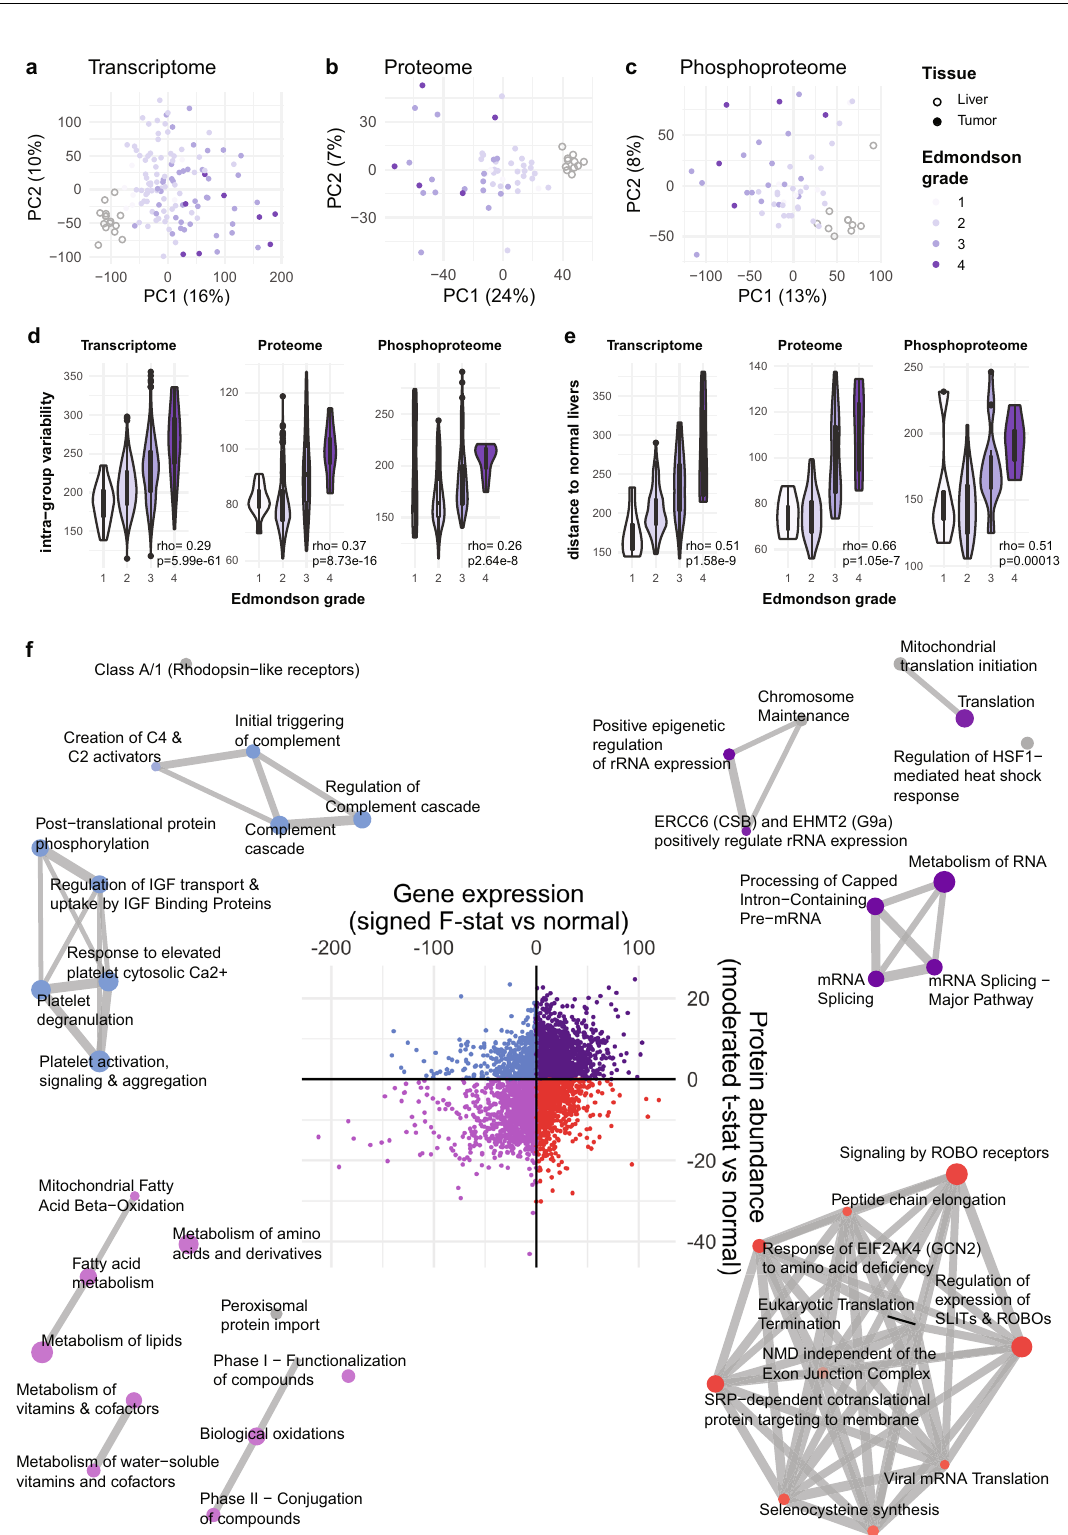
There were other candidate copy number-driven cancer genes implicated in oncogenesis (Fig. 2d inset and Supplementary Data 5). For example, NUDCD1 (NudC domain containing 1, or OVA66, 8q22.2) has been shown to promote colorectal carcinogenesis and metastasis by inducing epithelial-to- mesenchymal transition (EMT) and inhibiting apoptosis 19 and to promote oncogenic transformation by hyperactivating